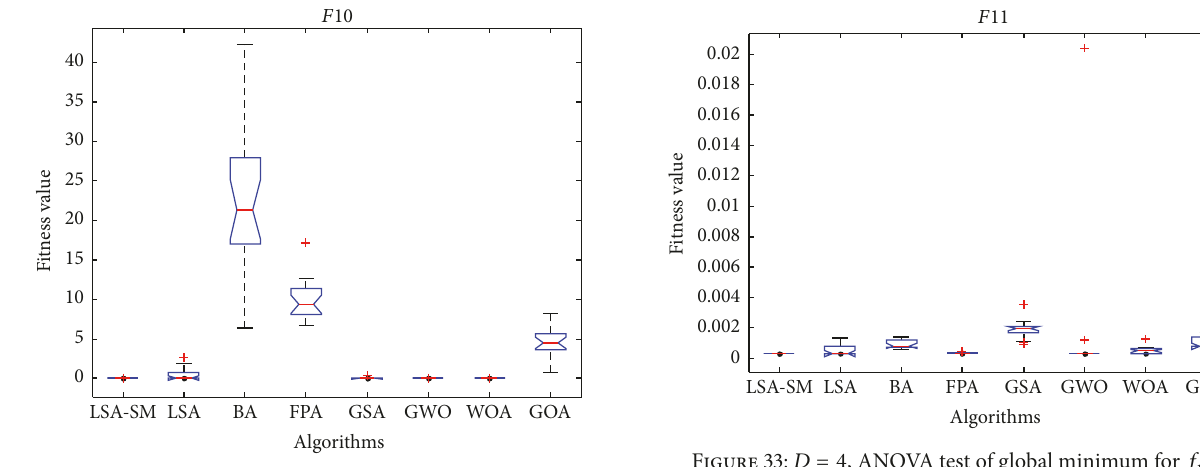
Figure 32: 𝐷 = 30 , ANOVA test of global minimum for 𝑓 10 .